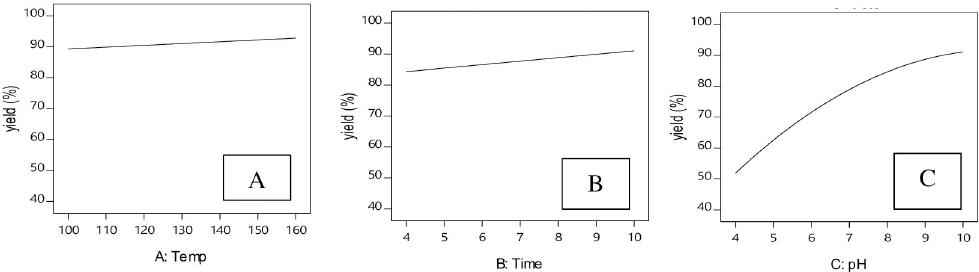
Fig 6. Effect of process parameters on reaction yield. A: Hydrothermal temperature, B: hydrothermal reaction time, C: